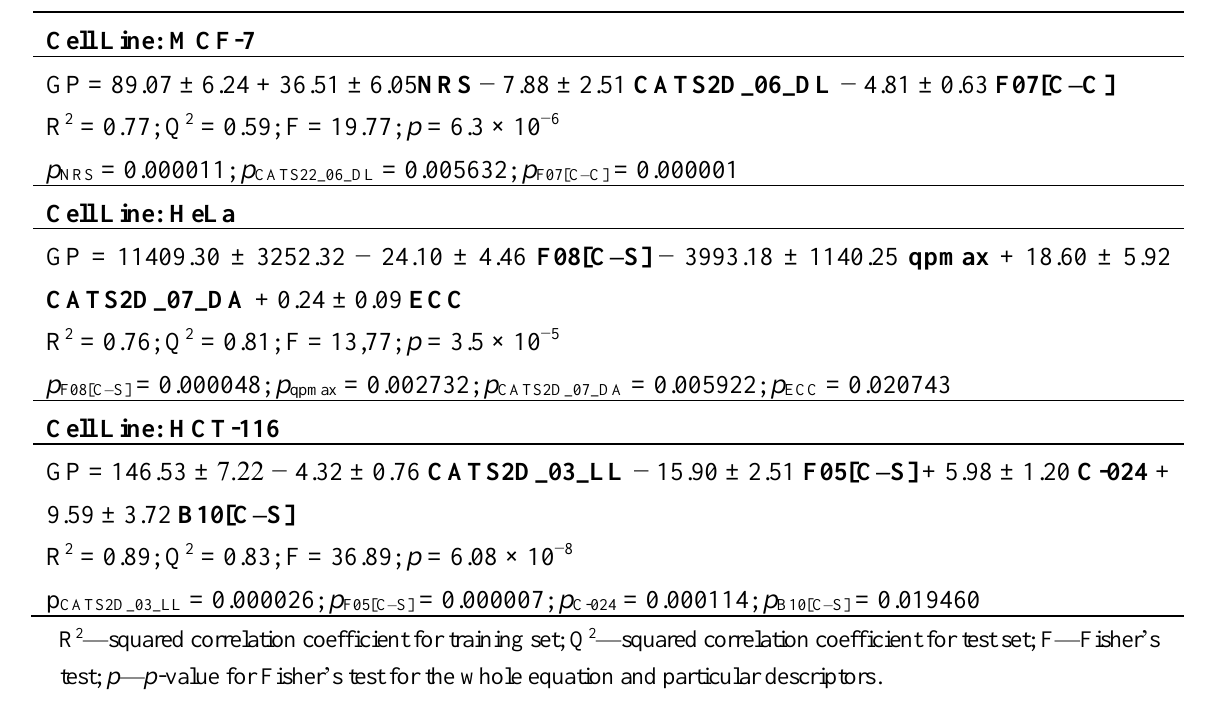
Table 7. Summary of the QSAR equations developed for compounds under the